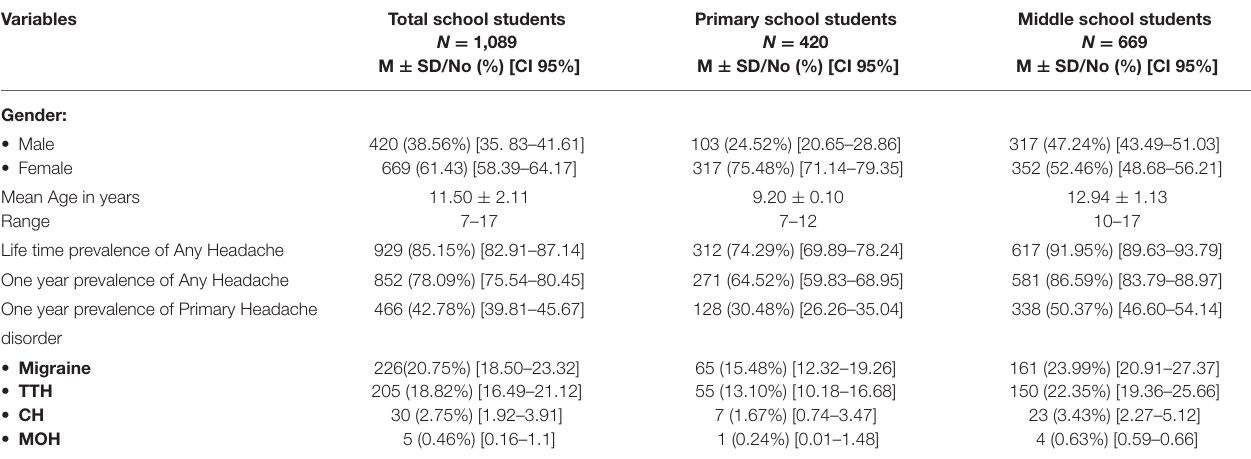
TABLE 1 | Demographic data and prevalence of headache among school students.